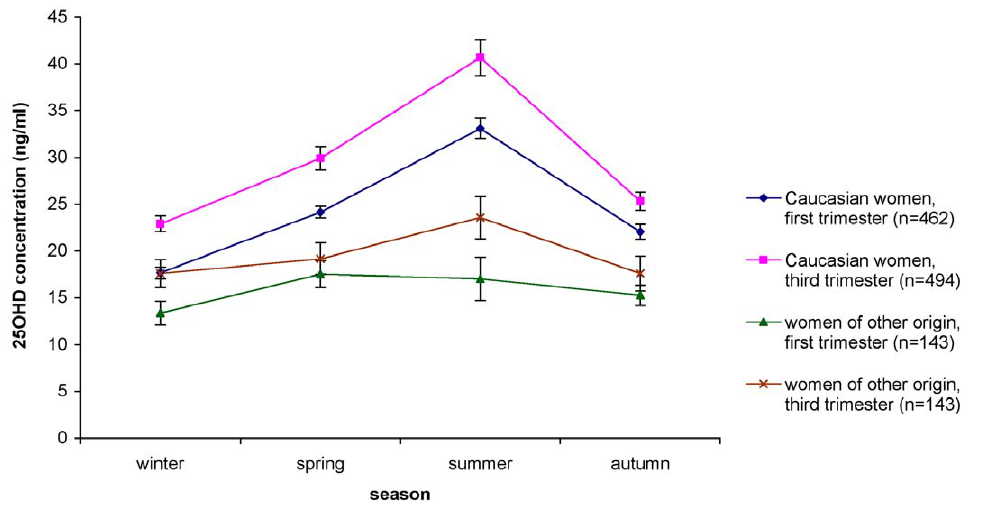
Figure 2. Serum 25-(OH)D concentrations over the different seasons, by trimester of pregnancy and ethnicity (national survey on vitamin D status among pregnant women in Belgium, 2010–2011).